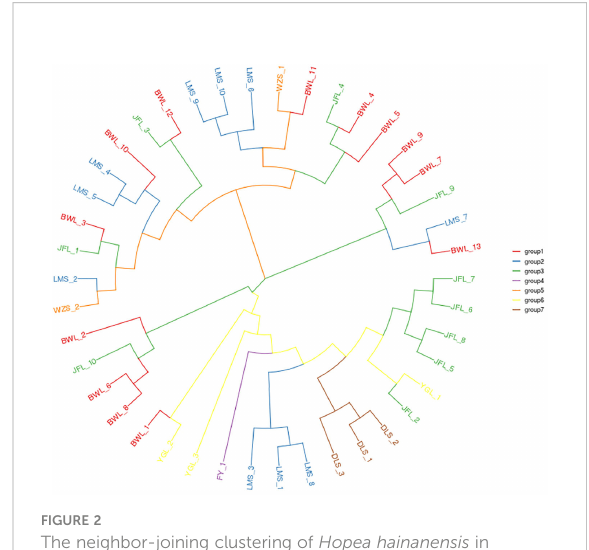
FIGURE 2 The neighbor-joining clustering of Hopea hainanensis in different